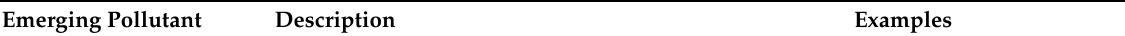
Table 1. Examples of some emerging pollutant (EP) classes and their